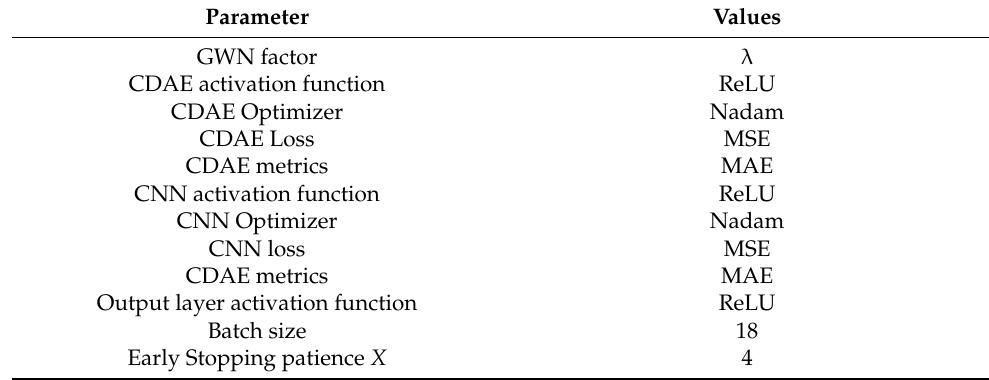
Table 1. Model parameter.